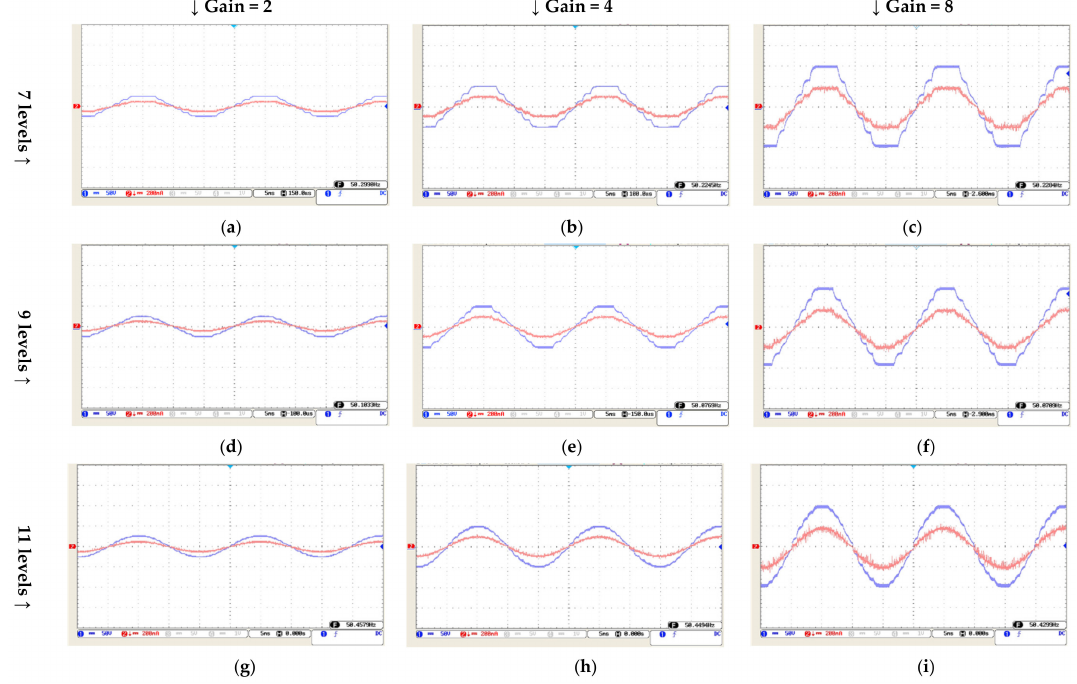
Figure 9. The experimental test waveform of output voltages and currents for the proposed multilevel inverter: ( a ) levels = 7, gain = 2; ( b ) levels = 7, gain = 4; ( c ) levels = 7, gain = 8; ( d ) levels = 9, gain = 2; ( e ) levels = 9, gain = 4; ( f ) levels = 9, gain = 8; ( g ) levels = 11, gain = 2; ( h ) levels = 11, gain = 4; ( i ) levels = 11, gain =